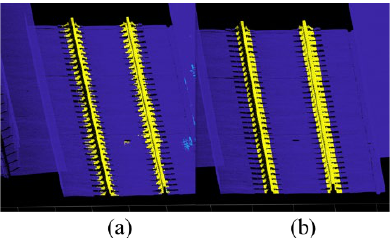
Figure 4. Prediction (a) and ground truth (b) of the rails’ region for the KPConv segmentation with transfer learning.